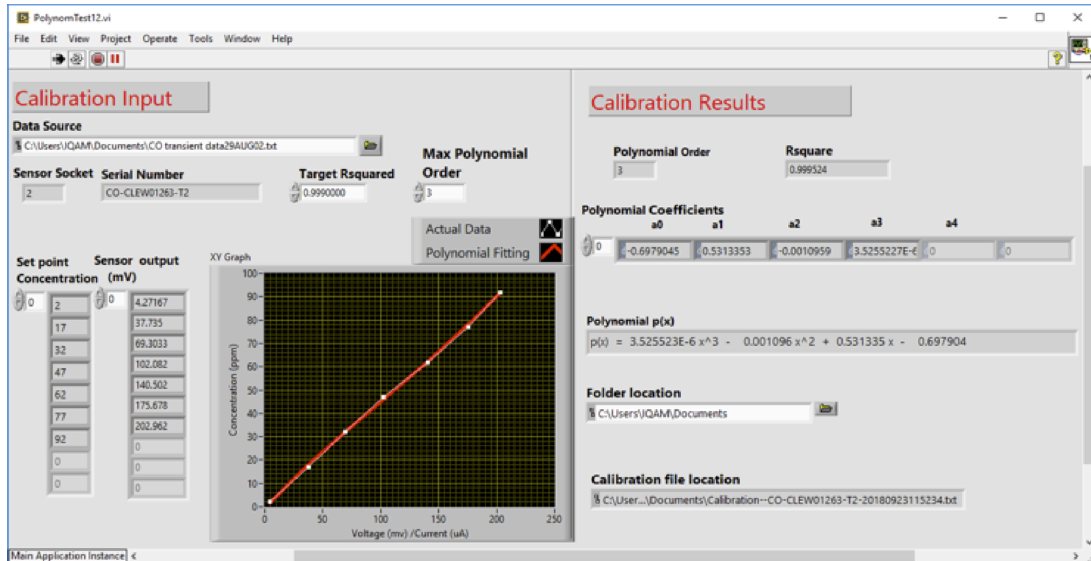
Figure 8. Graphical User Interface for the LabVIEW VI for the polynomial fitting.